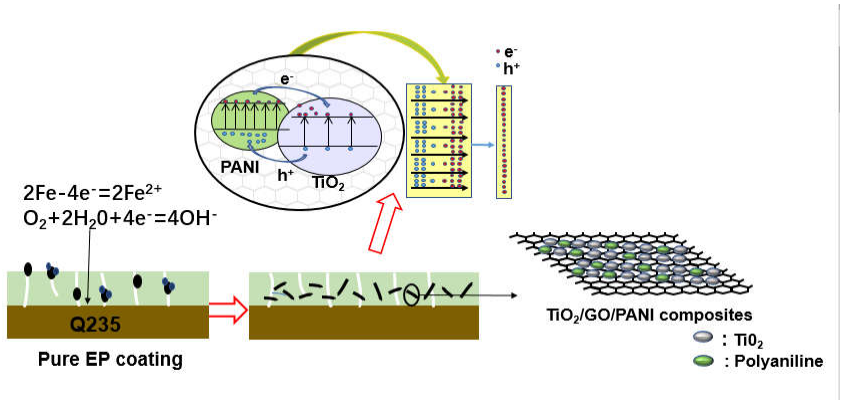
Figure 8. Corrosion resistance mechanism of TiO 2 /GO/PANI/EP coating .